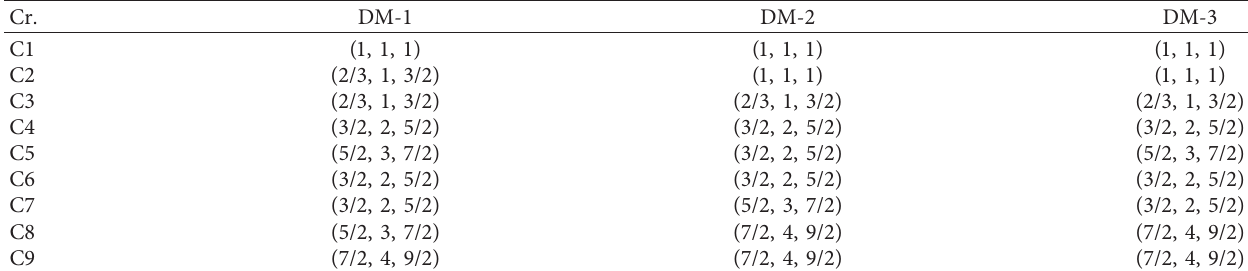
Table 7: Preference of best criterion with regard to each of the other criteria using TFNs (best-to-others vector).